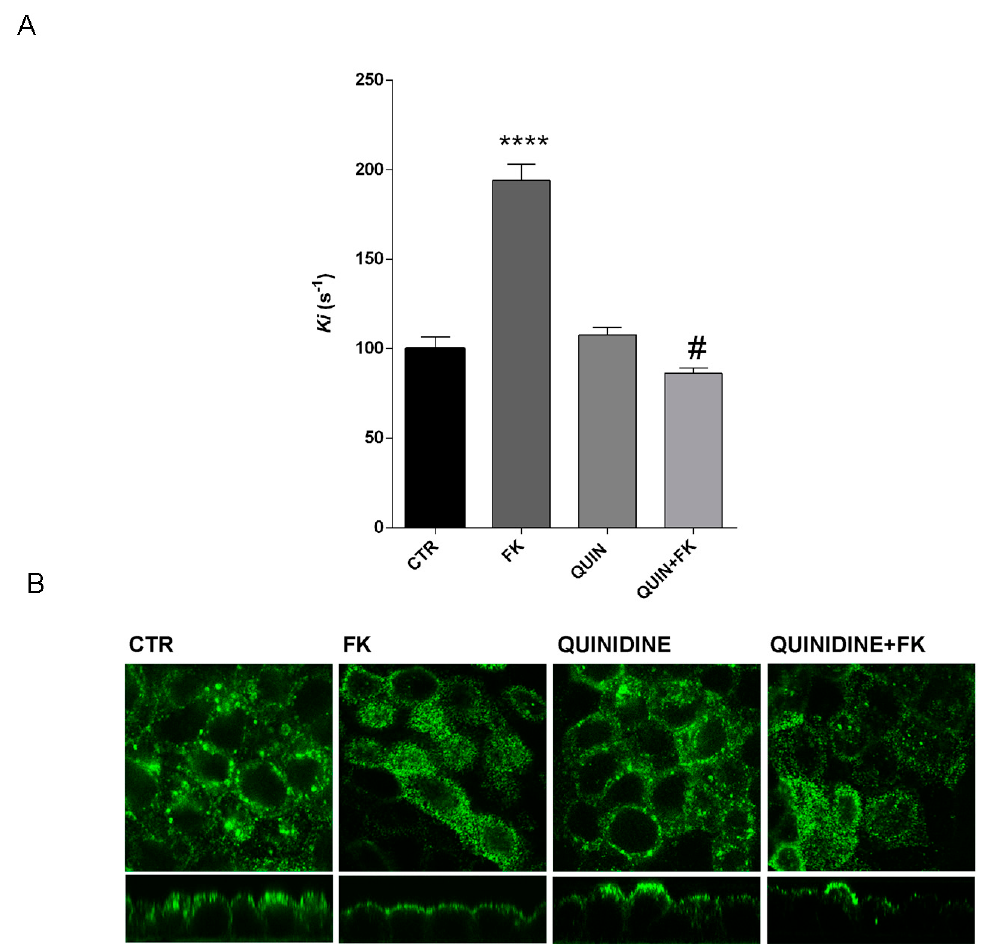
Figure 6. Effect of quinidine treatment on osmotic water permeability under FK action in MCD4 cells. ( A ) Cells were grown and treated with Forskolin (FK) 100 µ M and/or quinidine (10 µ M) as described in Experimental Procedures. Treatment with FK (100 µ M) induced a significantly higher temporal osmotic response reported as Ki (values are reported as means ± S.E.Ms; 194 ± 9.04 s − 1 , **** p < 0.0001) as compared to untreated cells (100 ± 6.65 s − 1 ). Quinidine (10 µ M) caused a significant reduction of FK response (86.40 ± 2.83 s − 1 , # p < 0.0001). Quinidine alone had no effect on the basal osmotic water permeability. ( B ) Immunolocalization and analysis by confocal microscopy of AQP2 localization in polarized MCD4 cells. Under basal condition, AQP2 staining was mainly intracellular. FK stimulation caused AQP2 translocation to the apical plasma membrane. In quinidine treated cells AQP2 relocation to the apical plasma membrane in response to FK was partially prevented.